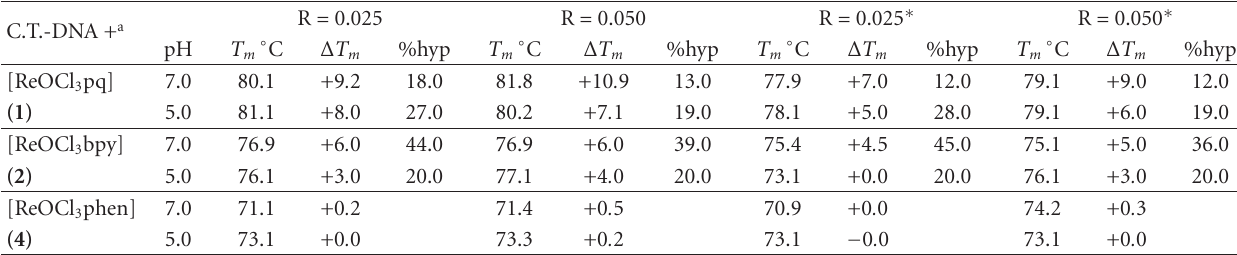
Table 2: Melting temperatures of CT-DNA in 10 mM bu ff er (pH 7.0 and pH 5.0) in the presence of complexes 1–3, before and after irradiation ( λ = 420–1000nm).